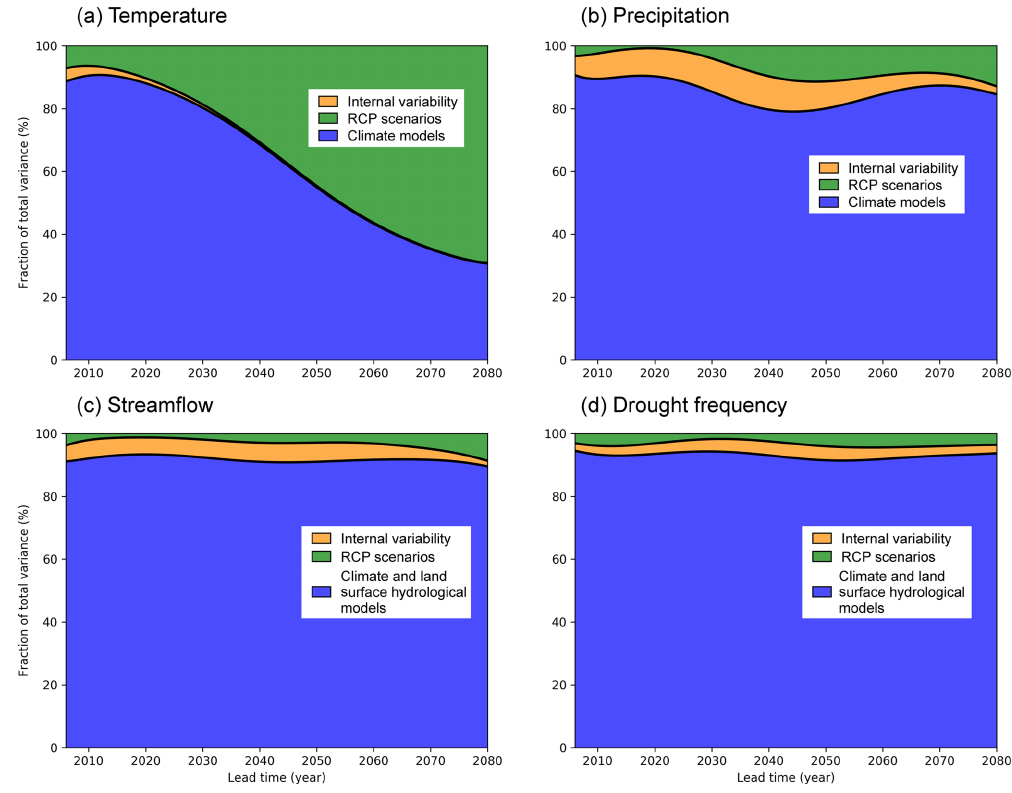
Figure 8. Fractions of uncertainties from internal variability (orange), RCP scenarios (green), and climate and land surface hydrological models (blue) for the projections of 20-year moving-averaged (a) temperature, (b) precipitation, (c) streamflow and (d) hydrological drought